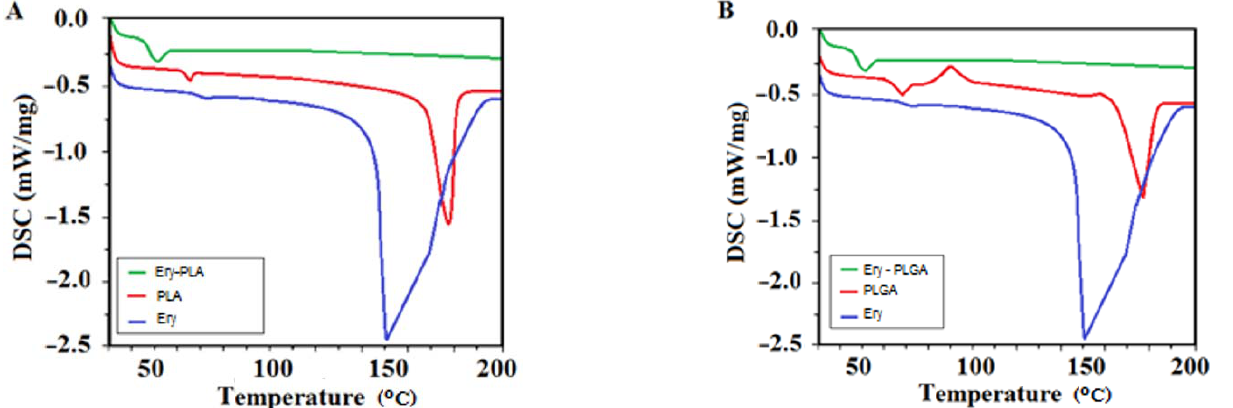
Figure 9. SEM images of ( A ) Ery ‐ PLA and ( B ) Ery ‐ PLGA.